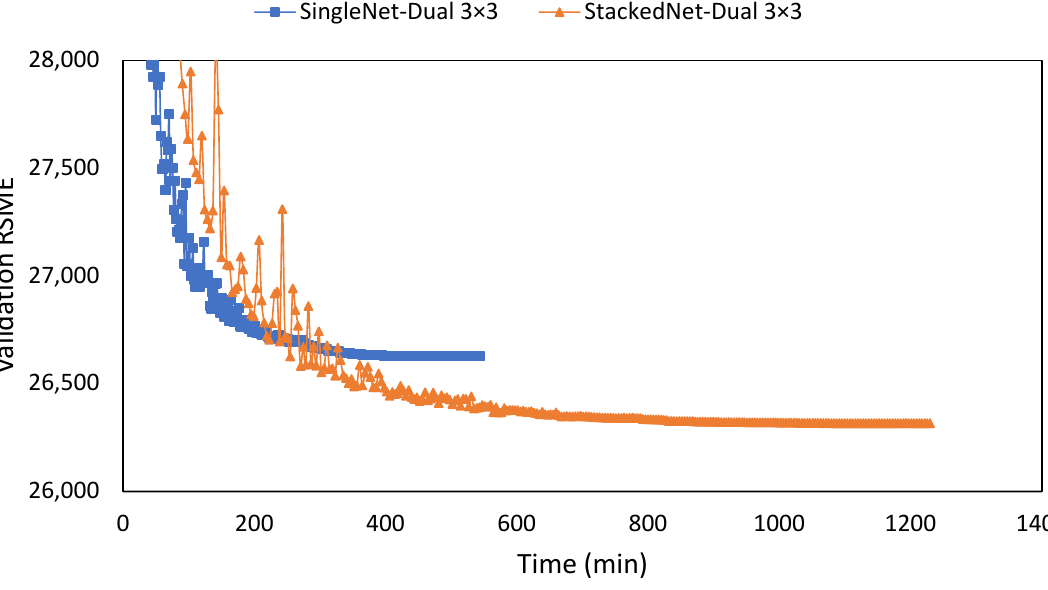
Figure 4. Training result between a normal-modified U-Net and the double stacked-modified U-Net on the same double layers with 3 × 3 filters. Rather than the epoch number, the X-axis represents time in minutes to show the training length for 300